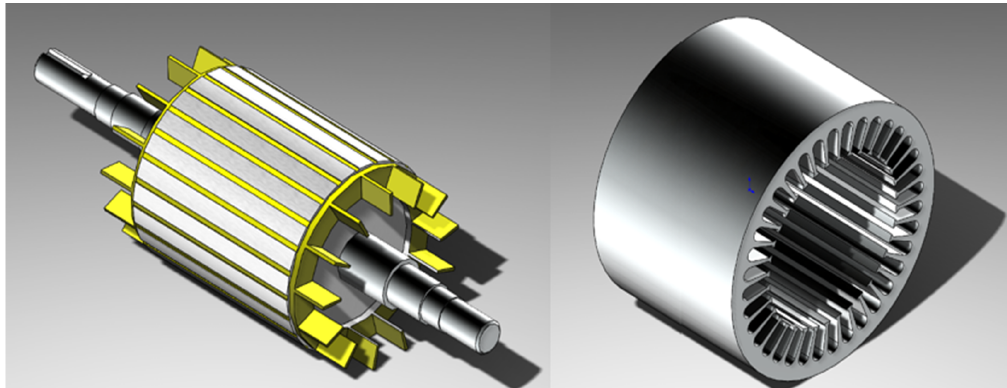
Figure 4. SolidWorks. Rotor and stator of induction motor.